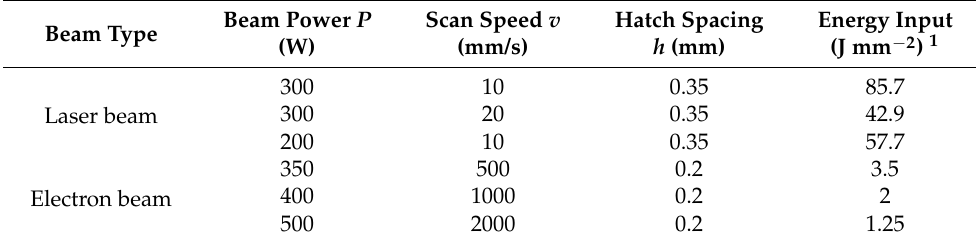
Table 3. Process parameters for laser and electron beam